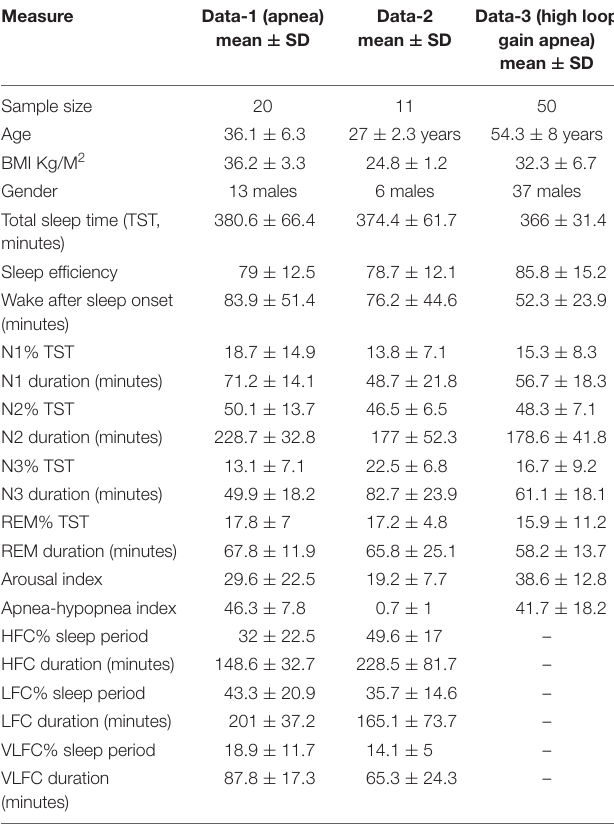
TABLE 1 | Subject characteristics, sleep stage and sleep state across datasets.